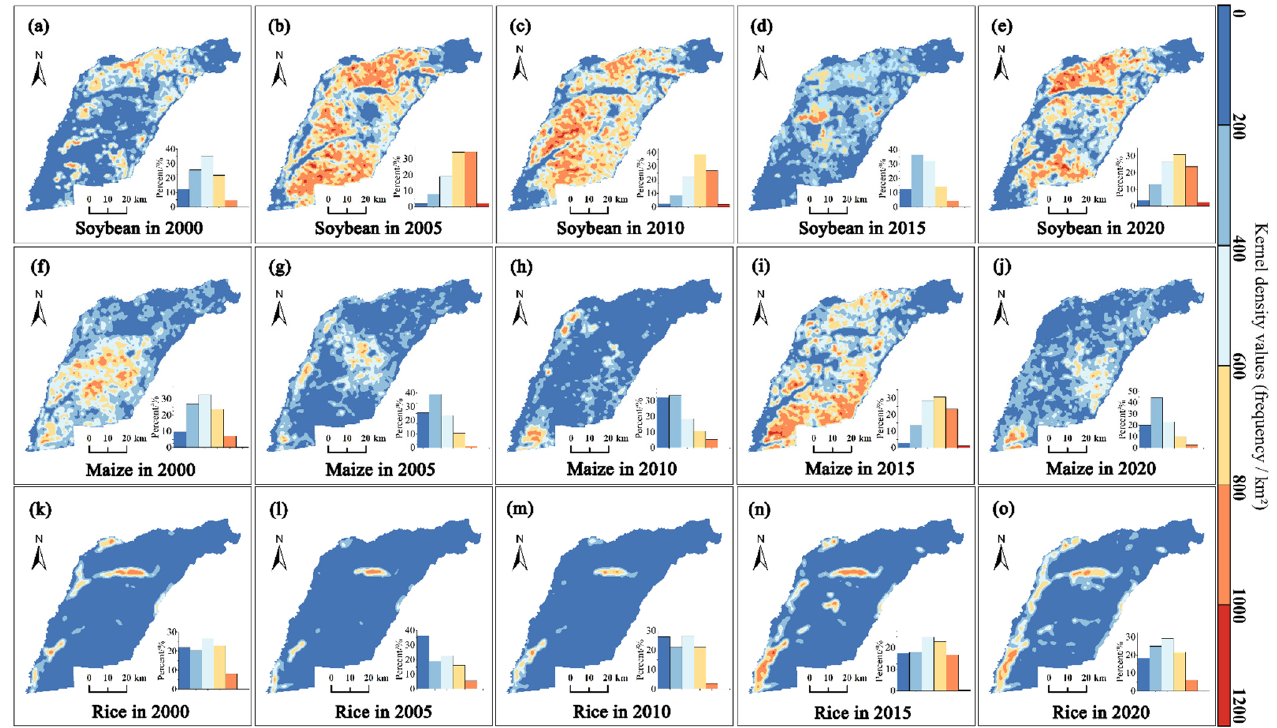
Figure 3. Kernel density of soybean ( a – e ); maize ( f – j ); rice ( k – o ) in 2000, 2005, 2010, 2015, and